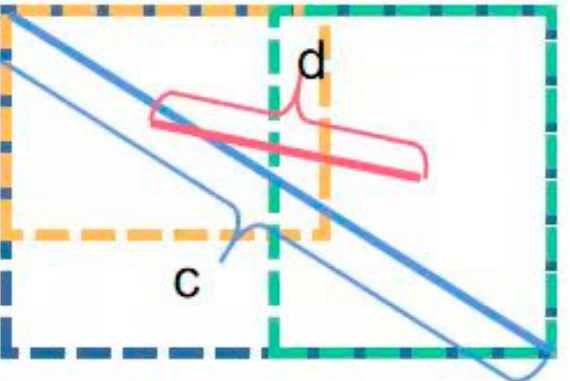
Figure 7. Schematic diagram of DIoU . c is the diagonal length of the smallest enclosing box